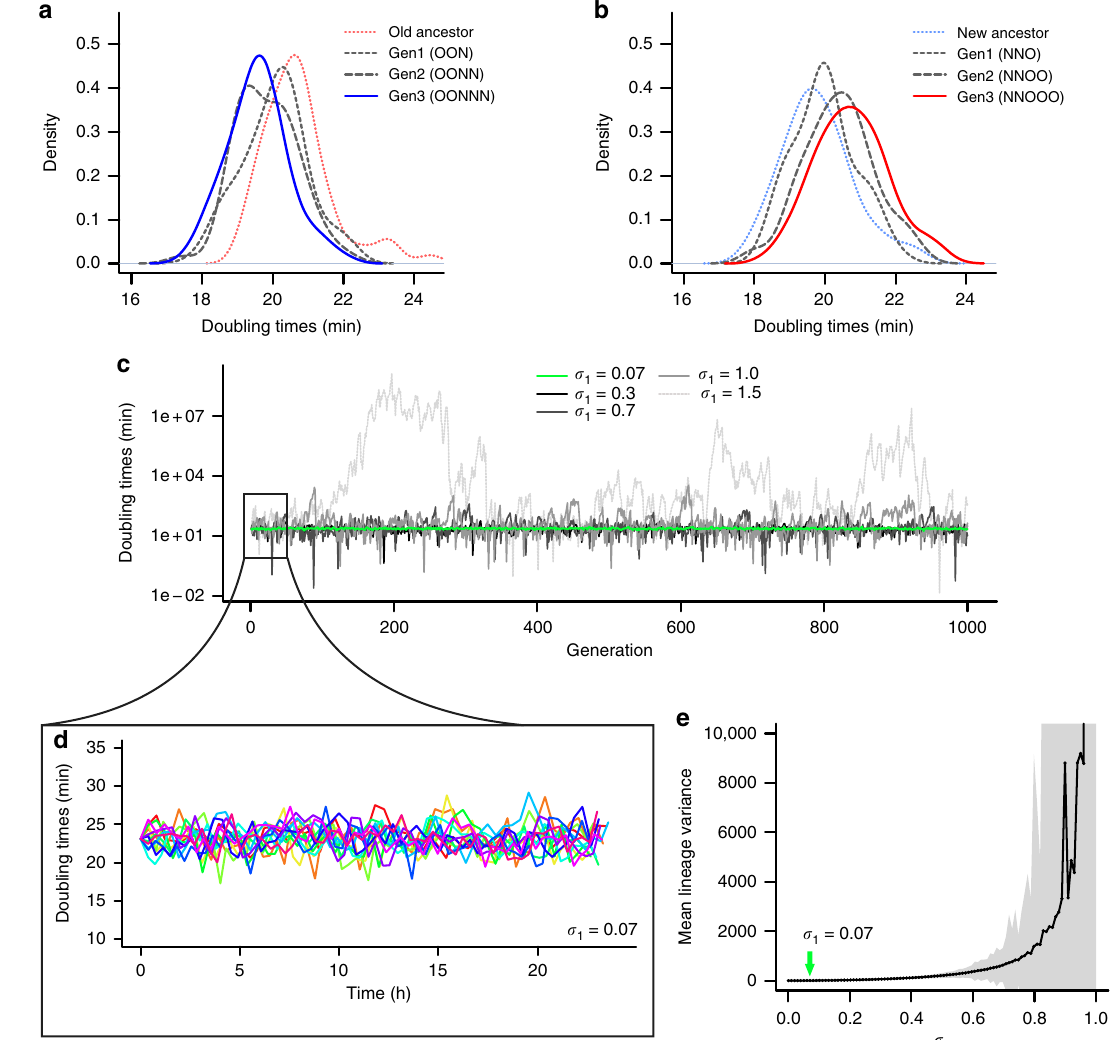
Fig. 5 Doubling time equilibria have attractive properties for displaced and stable lineages. a , b Displaced lineages from the daughter device. a The doubling time distribution of a new lineage born from an old ancestor at the T2 equilibrium shifts towards shorter doubling times with each generation. After three generations of rejuvenation, the distribution becomes centered at the T1 equilibrium. b The opposite pattern appears from old lineages generated from the new equilibrium, which converge towards the T2 attractor over generations (Supplementary Table 5). c , d , e Evaluation of stochasticity in silico based on mother machine data (Fig. 3). c Doubling times of in silico old lineages starting from the T2 equilibrium, for increasing values of σ 1 in T2 = T0*( a + σ 1 ) + b + σ a 2 + σ = 0.07, the maximum stochasticity expected 2 ≥ 1. d Doubling times generated for σ 2 (Supplementary Note 1). Stochasticity disrupts stability if 1 1 from our experimental data. e Mean doubling time variance of in silico old lineages followed for 100 generations (5000 replicates) for a range of σ 1 values (0.0001 to 1). When σ 1 > 0.94, the stability requirement a 2 + σ 1 2 < 1 is no longer ful fi lled. Shaded area represents